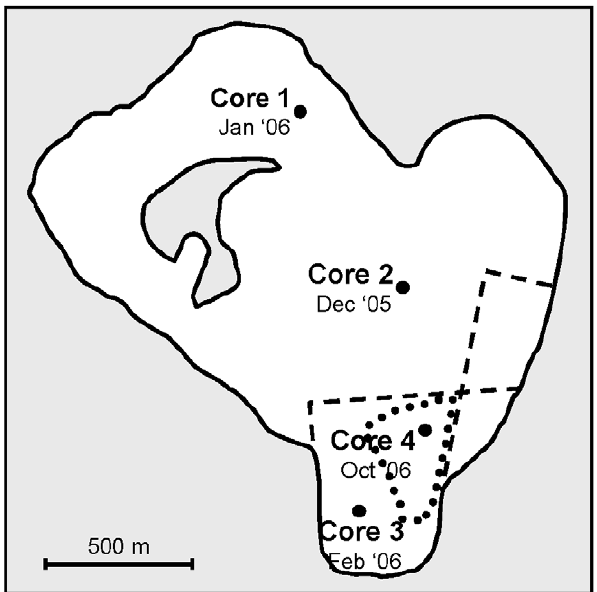
Figure 1. Location and date of sediment core sampling in Pe´trola lake. Dashed lines show dikes of a disused salt evaporation plant that divide the lake into compartments. The more southern compartment receives the inflow of freshwater from a nearby sewage treatment plant. Dotted lines show the area with remaining water during a summer drought in August 2007 (from an aerial photograph in Google Earth 4.7). Note that Core 4 was obtained in the deeper point of the